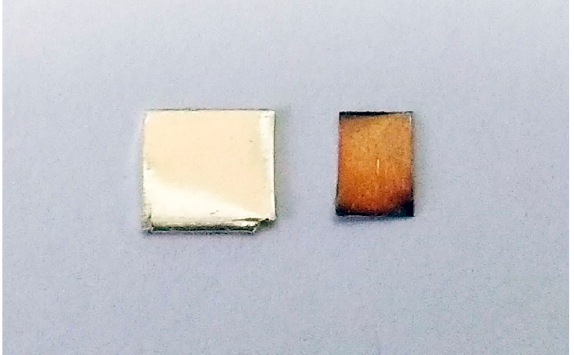
Table 1. Crystal structure of acanthite Ag 2 S [24].